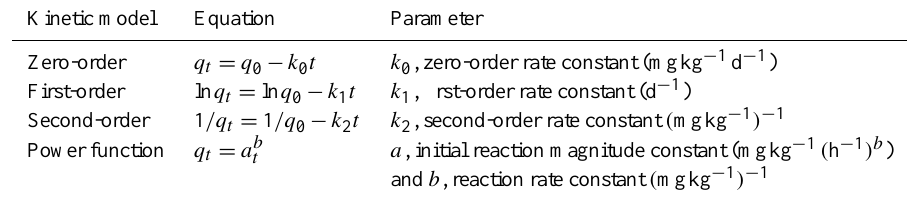
Table 6. Kinetic models used for the study of copper fixation in selected semiarid alkaline soils of the Southern High Plains, USA.